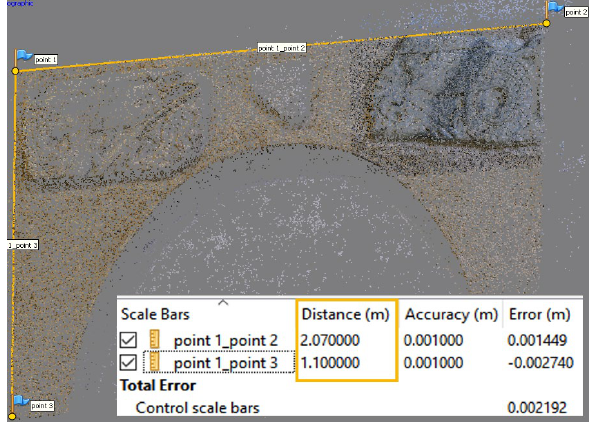
Figure 5. Scaling acquired panels using a known distance